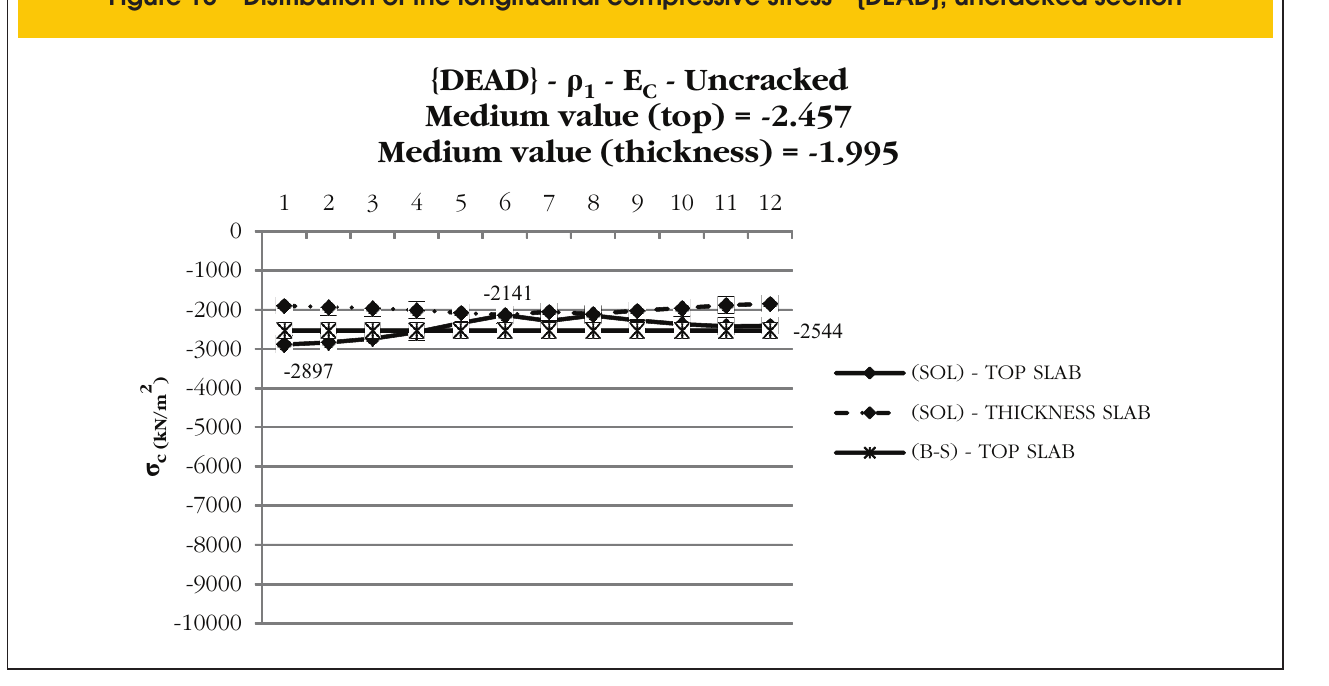
Figure 13 – Distribution of the longitudinal compressive stress - {DEAD}, uncracked section